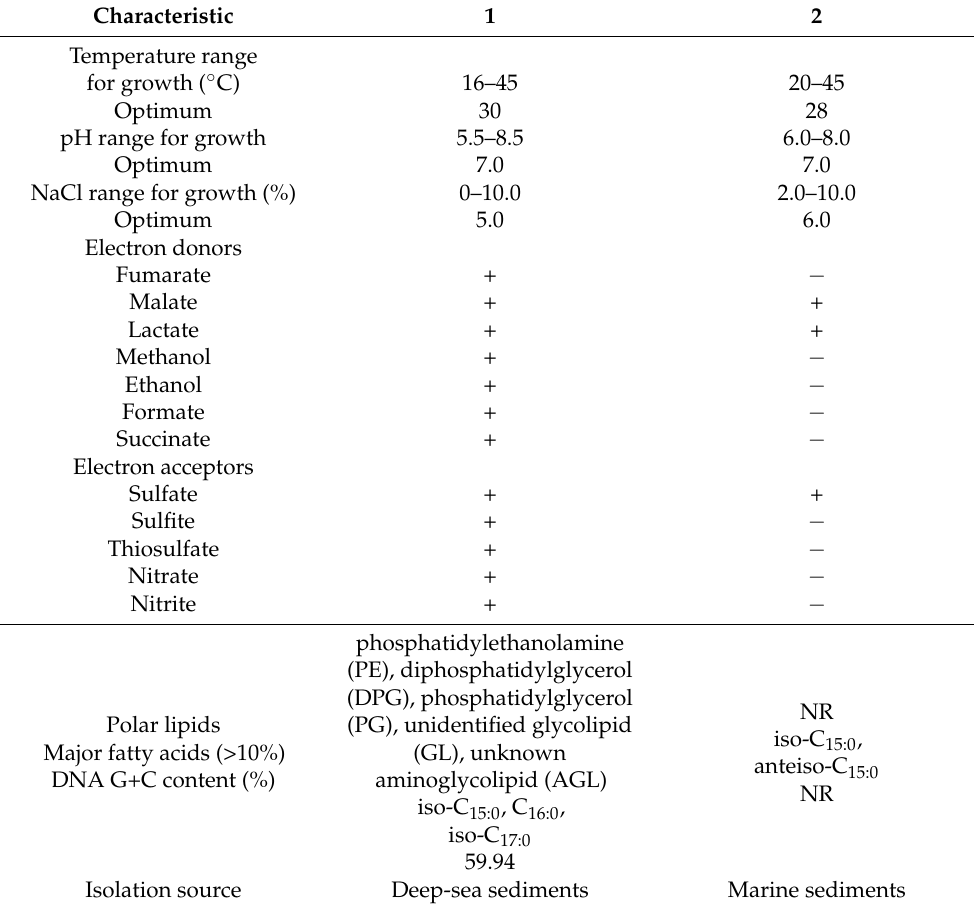
Table 1. Differential physiological characteristics of P. cashew SRB007 T and the closely related type strain P. profundus DSM 11384 T . Strains: 1, P. cashew SRB007 T (all data from this study); 2, P. profundus DSM 11384 T (all data from this study except DNA G+C content and polar lipids). + , Positive result or growth; − , negative result or no growth; NR, not reported.